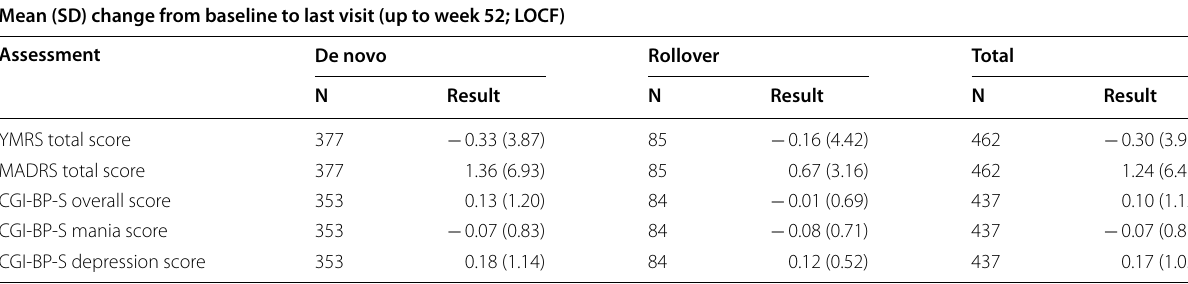
Table 2 Change in clinical stability indicators during the AOM 400 maintenance phase Mean (SD) change from baseline to last visit (up to week 52; LOCF)